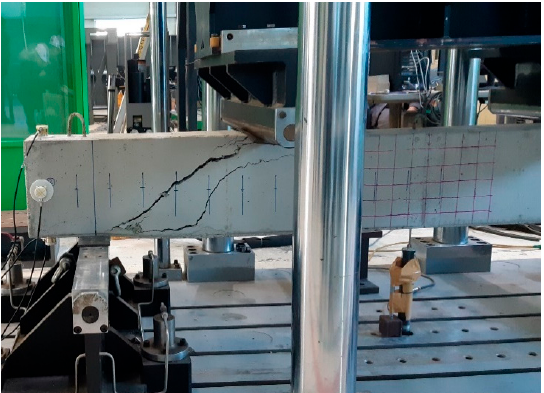
Figure 5. Load vs. displacement plot.